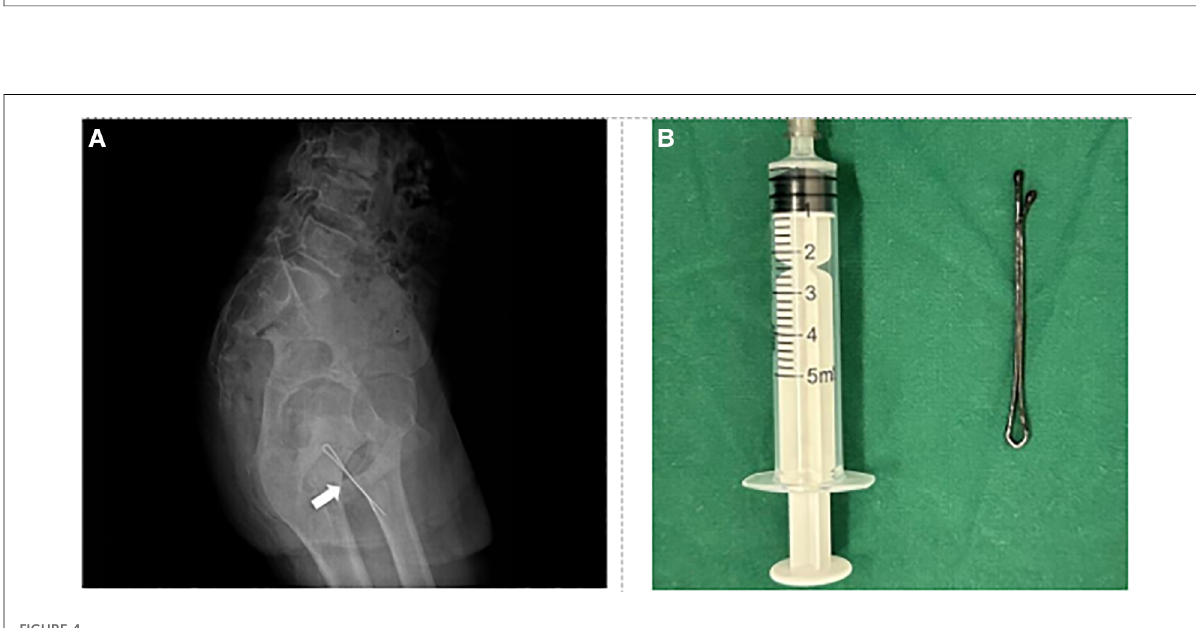
FIGURE 4 Preoperative imaging data and foreign body. ( A ) Plain fi lm x-ray shows the urethral foreign body (see arrow). ( B ) Foreign body is a hairpin about 6 cm